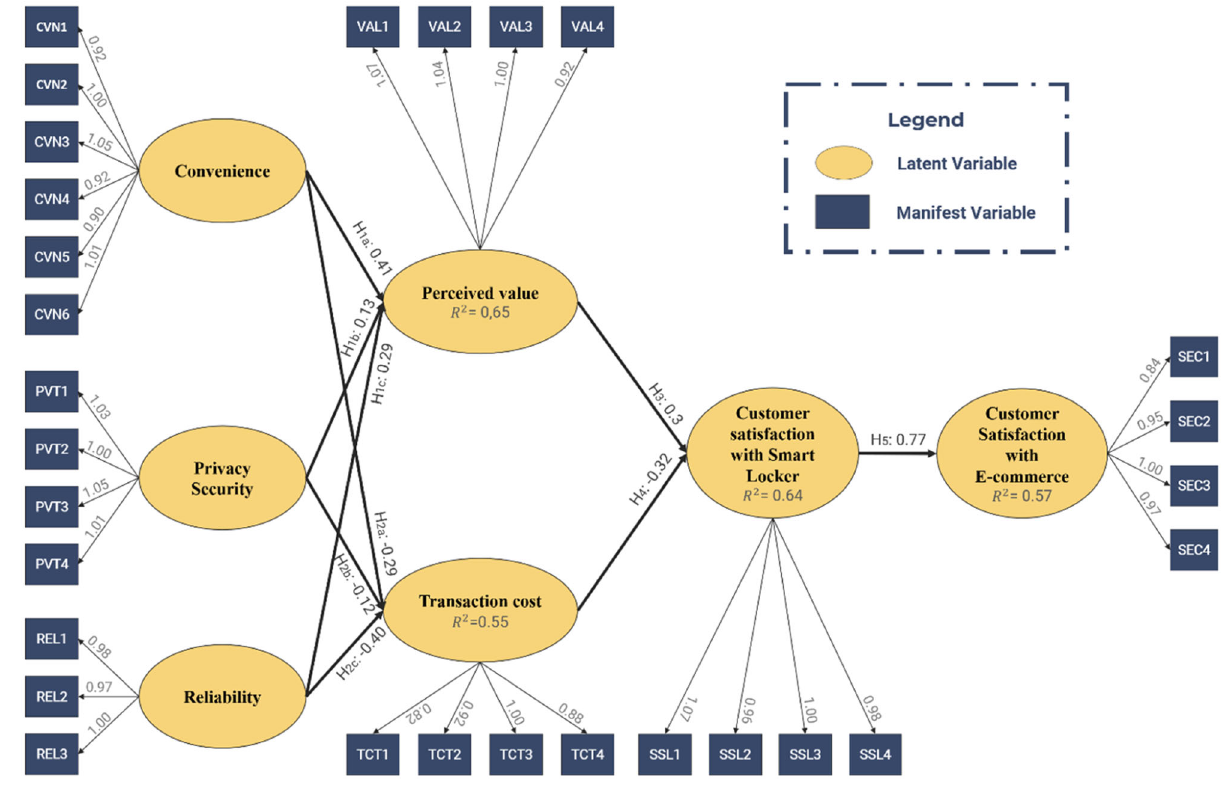
Fig. 2 Structural equation model. Note: SEM model fi t indices: Chi-square/df = 1.933; GFI = 0.905; CFI = 0.960; TLI = 0.956; RMSEA = 0.046.